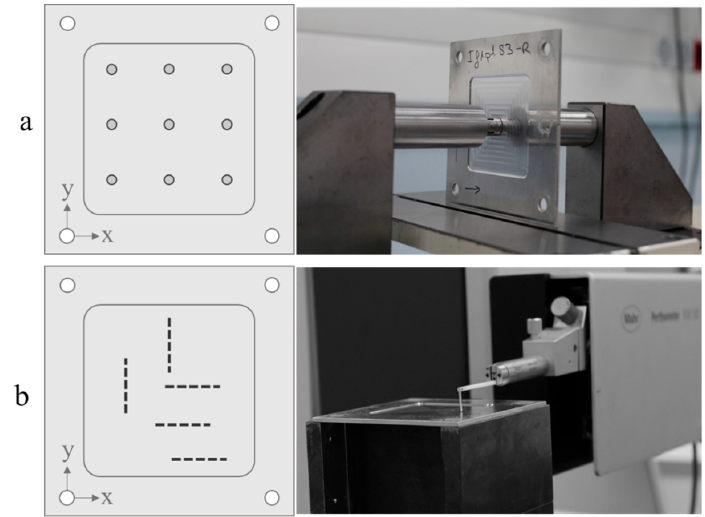
Figure 2. Measure procedure. ( a ) points selected for the thickness analysis and ( b ) areas studied for the roughness